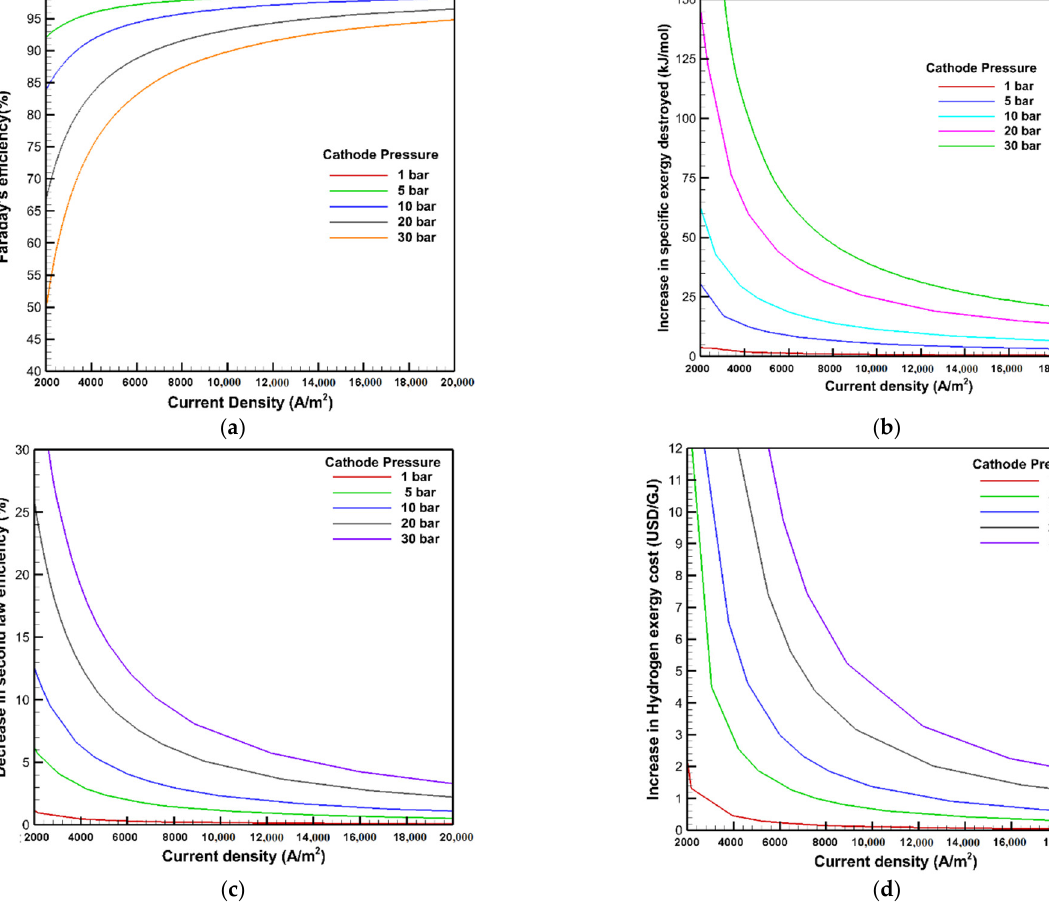
Figure 9. Effects of cathode pressure on: ( a ) Faraday’s efficiency; ( b ) the increase in exergy destroyed; ( c ) the decrease in second law efficiency; and ( d ) the increase in hydrogen exergy cost.